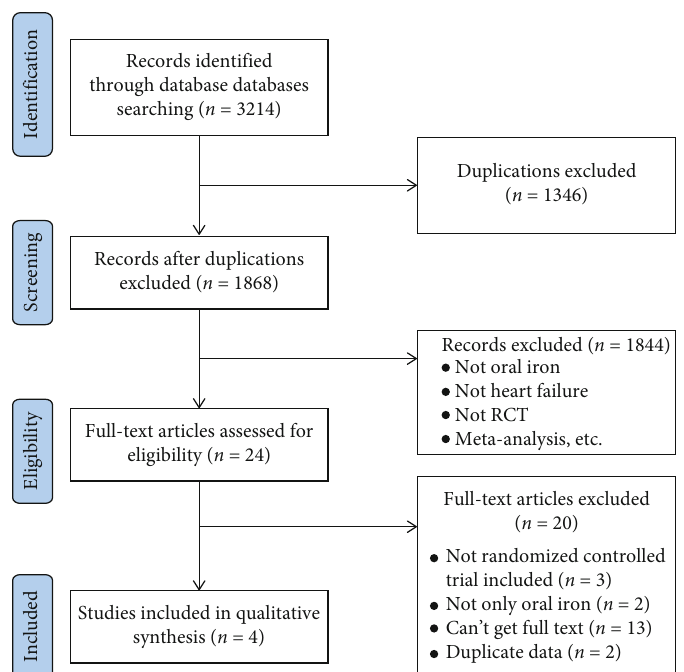
Figure 2: PRISMA fl ow diagram for selection of